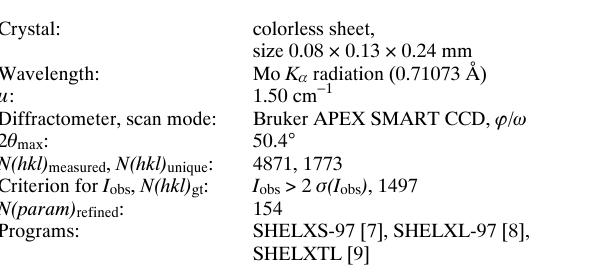
Table 1. D a t a collection a nd h a ndling.